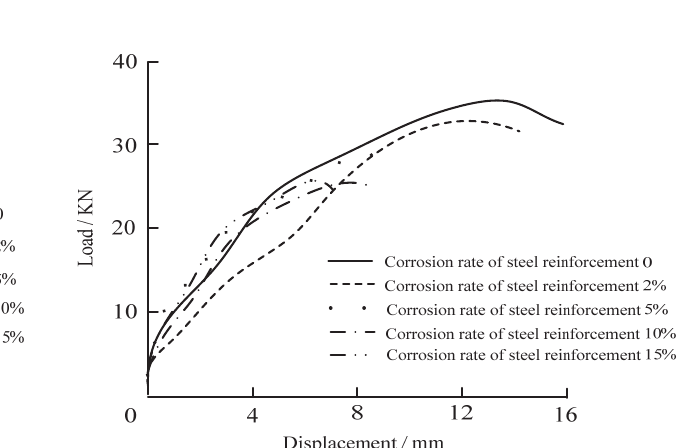
Figure 8: Curves of load-displacement (axial compression ratio 0.2).